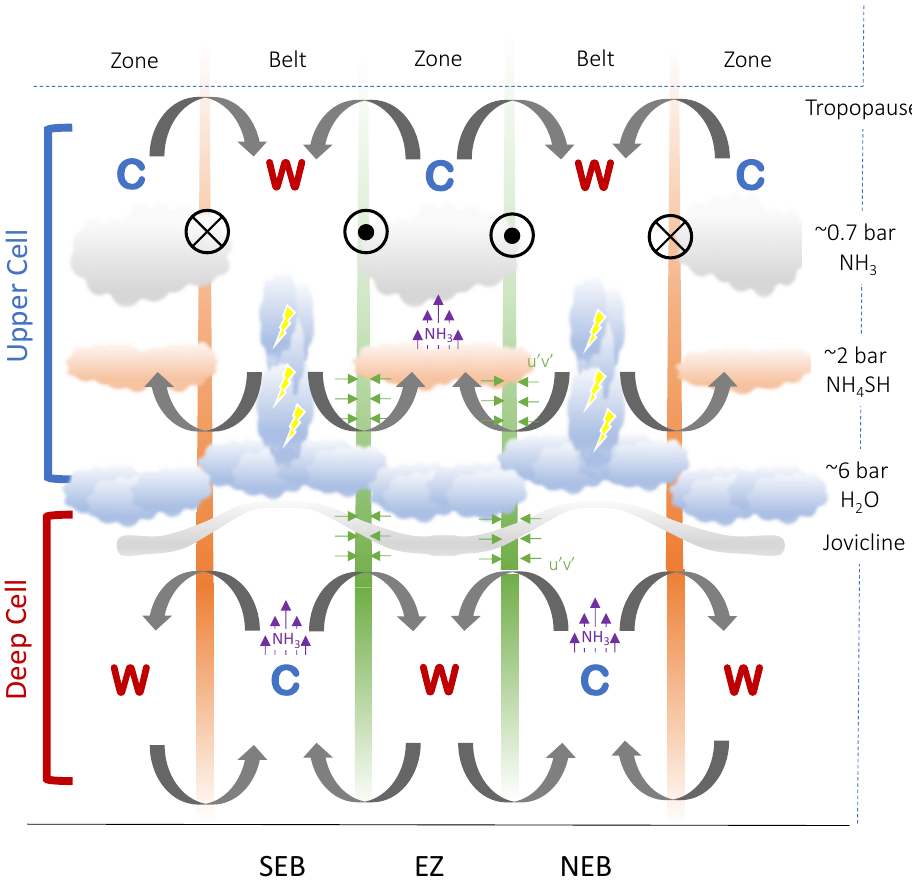
Figure 22. Illustration of the stacked system of meridional cells for Jupiter [93,153]. A red “W” stands for high microwave brightness temperature, and in the upper cell also for high temperatures in the mid-IR; the blue “C” indicates a low microwave brightness temperature, and in the upper cell also for low temperatures in the mid-IR. Eastward prograde jets are green (with a circular dot indicating motion out of the page) with eddy-momentum flux convergence (small green arrows); westward retrograde jets are orange (with a circular cross indicating motion into the page). The coloration of the green and orange bars indicate wind strengthening through the upper cell and wind decay with depth in the deep cell (“dry convective layer”). The Jovicline is shown in gray, co-located with the stable stratification of the water cloud. (Adapted from Fletcher et al.